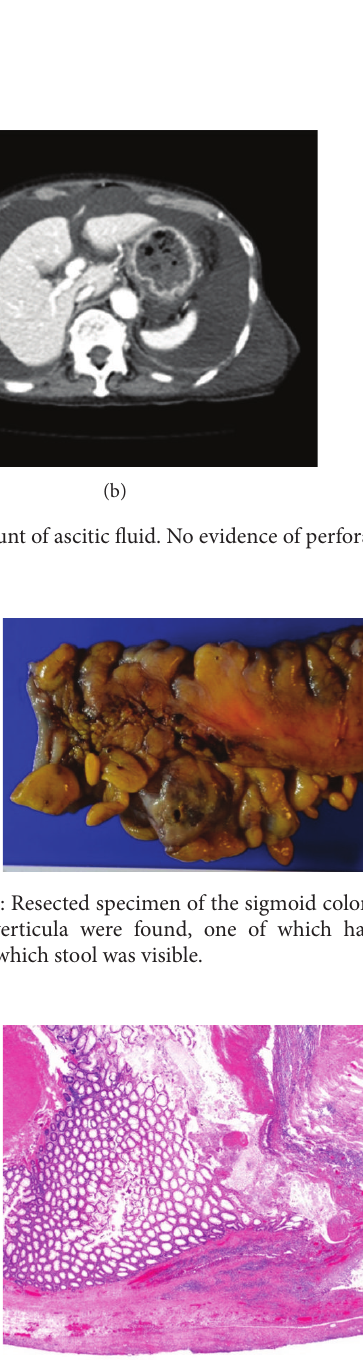
Figure 7: Histopathological findings. Diverticular perforation with neutrophilic infiltration of the surrounding